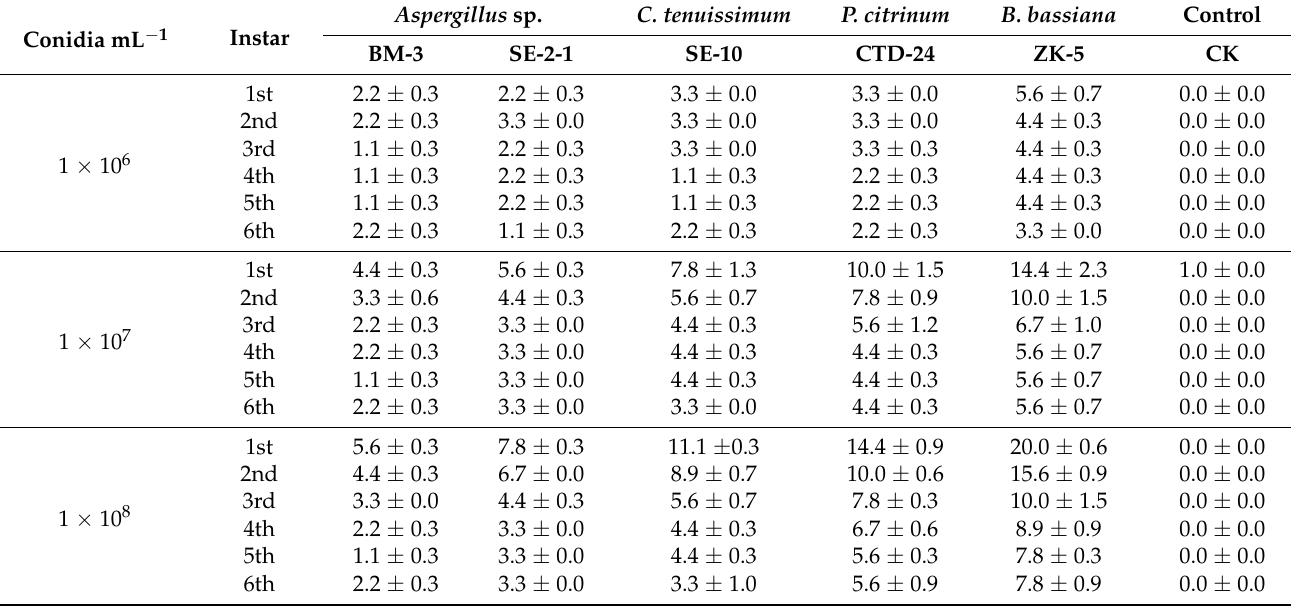
Table 3. Effects of fungal isolates on percent mortality of the sixth instar S. frugiperda larvae at three different concentrations. Aspergillus sp. C. Conidia mL − 1 Instar